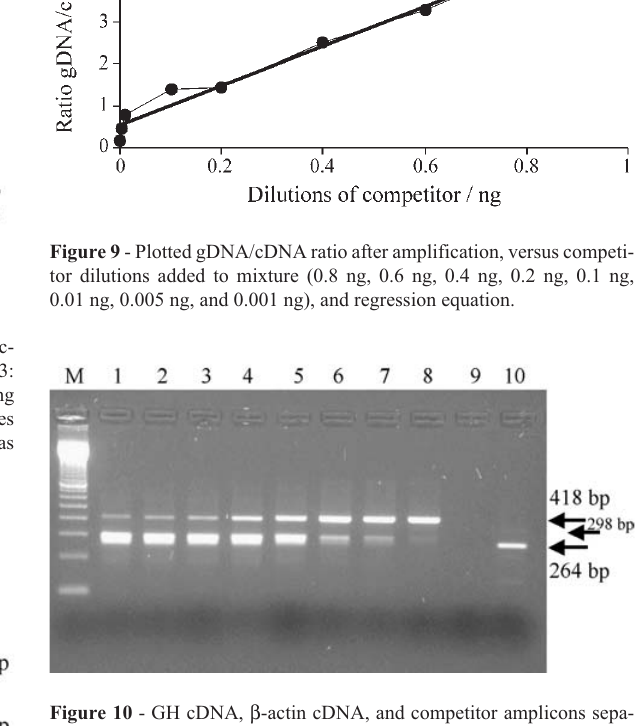
Figure 10 - GH cDNA, β -actin cDNA, and competitor amplicons sepa- rated by 1.5% agarose gel electrophoresis Lane M: 100-bp DNA molecu- lar weight markers; Lanes 1-8: Competitive RT-PCR products using 0.8 ng, 0.6 ng, 0.4 ng, 0.2 ng, 0.1 ng, 0.01 ng, 0.005 ng, and 0.001 ng of 298-bppurifiedDNAascompetitortemplate,and20ngoftotalRNA.The 264-bp band represents the β -actin cDNA used for quality control (Lane 10), and Lane 9 shows the negative